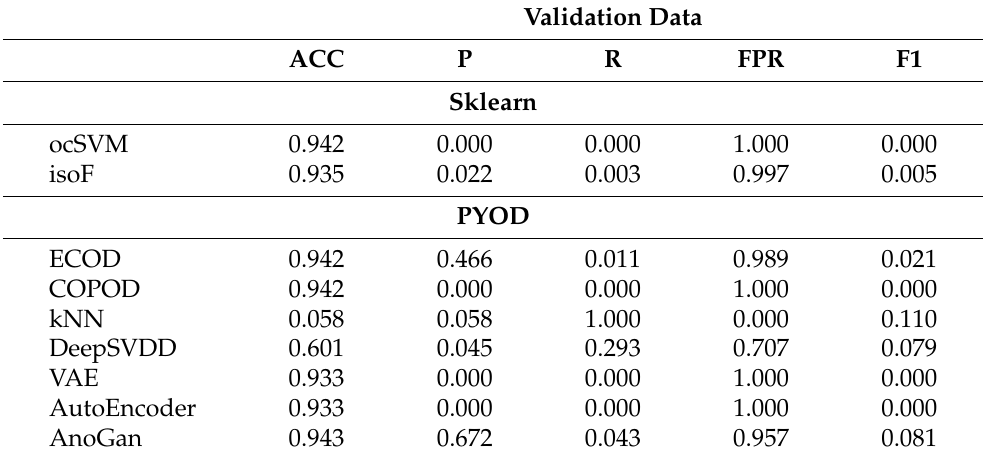
Table 7. The results of Experiment 2 for the SWaT dataset (for validation data).